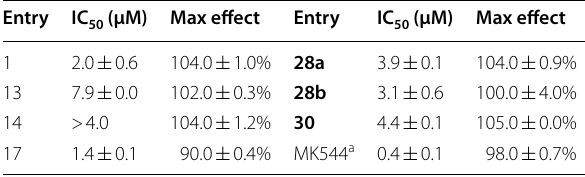
Values are averages of three determinations a MK544: a triazole type selective 11 β -HSD1 inhibitor developed by Merck, which was used as the positive control